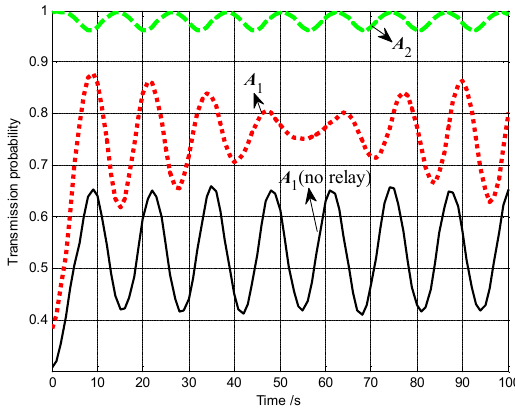
Figure 20. The probabilities of successful transmission of A 1 and A 2 to base station (Group A in Scenario 2).